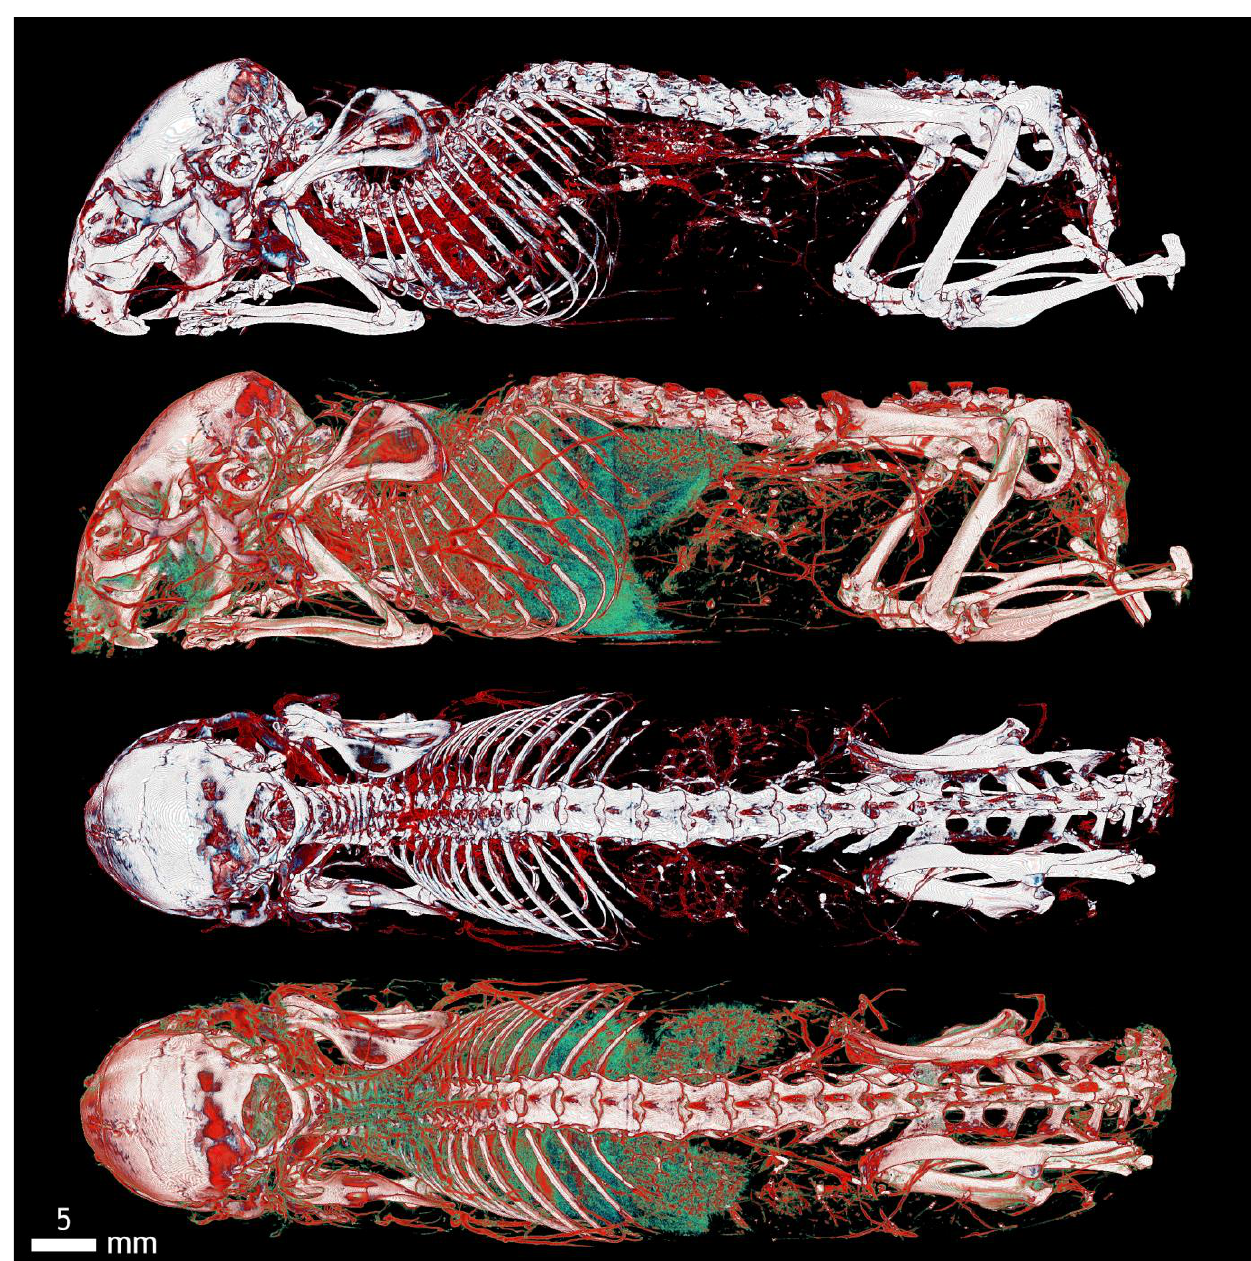
Figure A4. Color resolution of mouse vessels on the body surface (red) and internal organs (green).